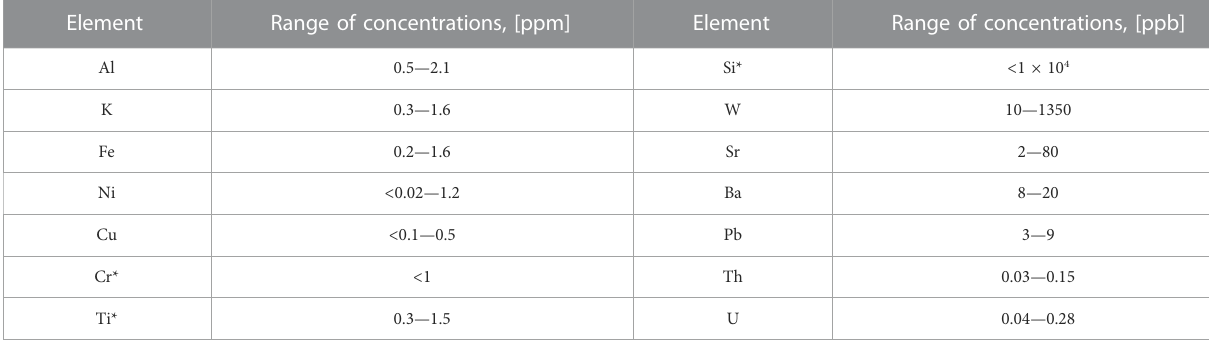
TABLE 1 Range of concentrations for measured contaminants in different lots of raw 100 MoO 3 powder. * Data of the producer. Element Range of concentrations,